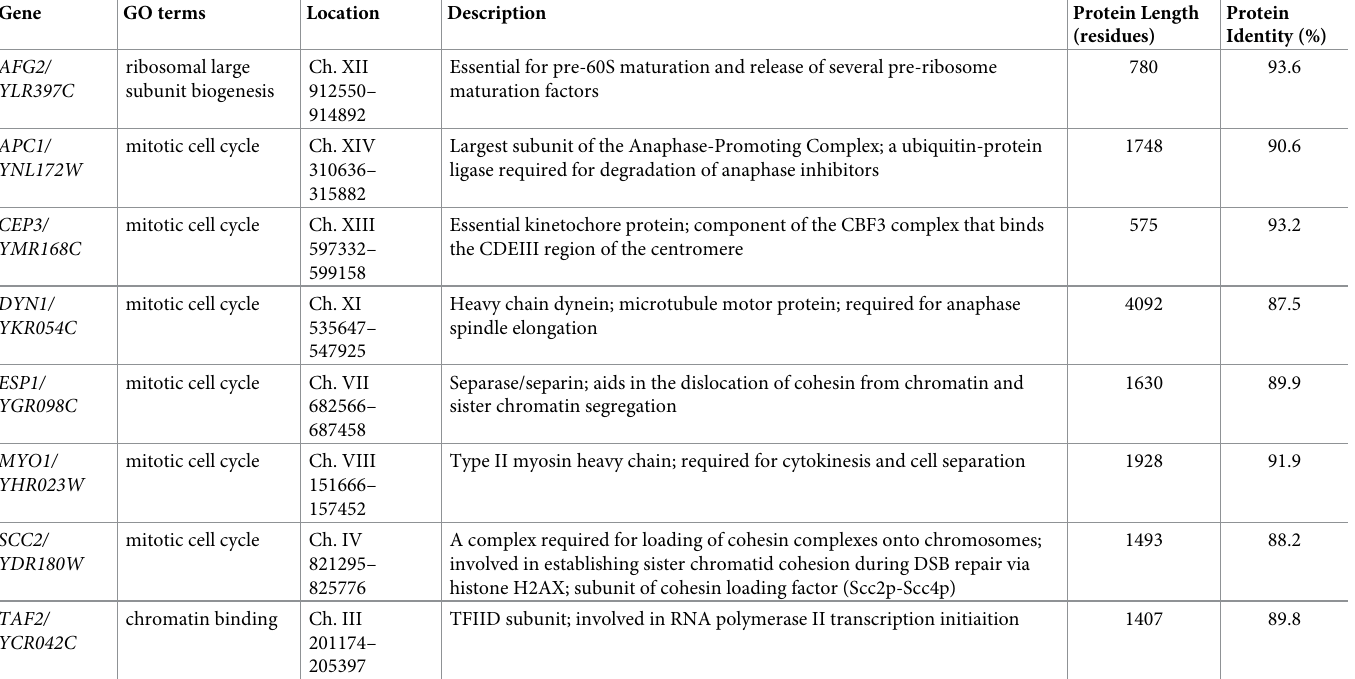
Table 1. Genes contributing to thermotolerance divergence between Saccharomyces cerevisiae and S . paradoxus . GO, Gene Ontology biological process. The last col- umn reports amino acid divergence between S . cerevisiae DBVPG1373 and S . paradoxus Z1. Gene GO